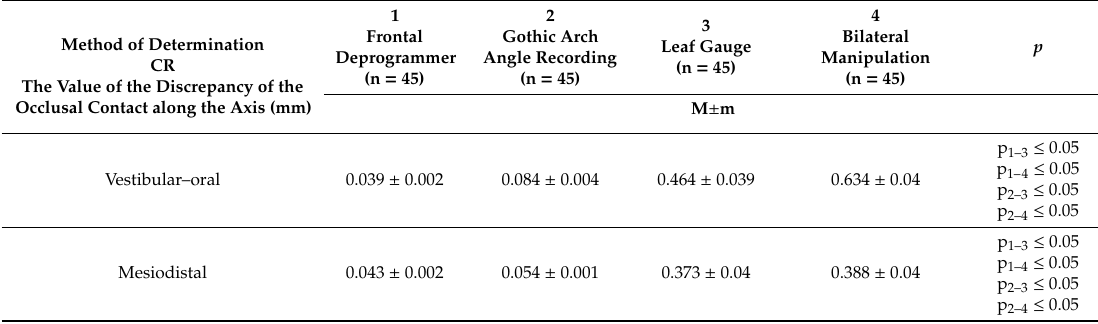
Table 2. Comparative analysis of occlusal contacts during CR determination in various ways. Method of Determination CR